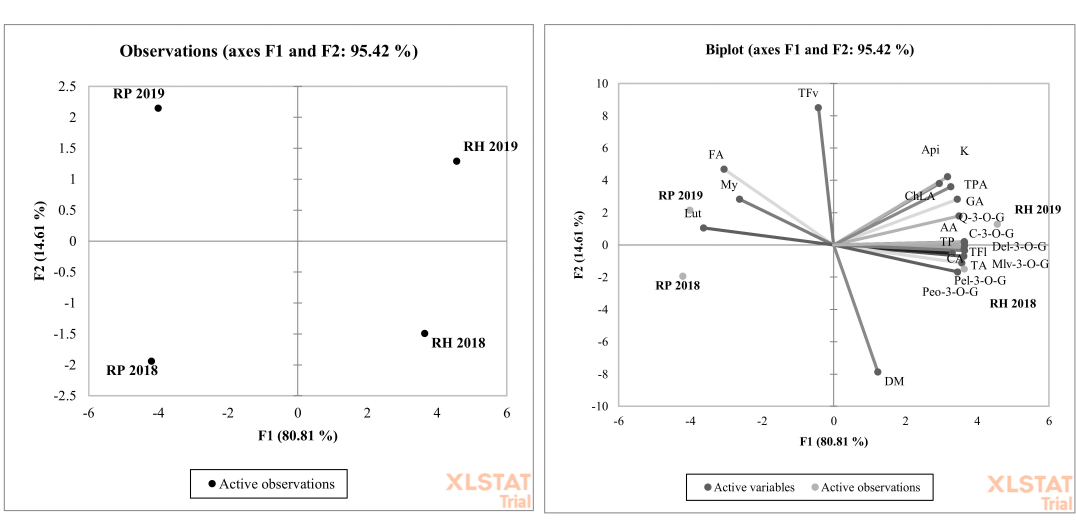
Figure 5. Principal component analysis (PCA) showing the relationship between the polyphenols composition and Robinia species: Robinia pseudoacacia L (RP), Robinia hispida (RH) in two years (2018 and 2019) of experiment. Dry matter (DM,) total polyphenols (TP), total phenolic acids (TPA), gallic acid (GA), ca ff eic acid (CA), ferulic acid (FA), chlorogenic acid (ChLA), total flavonoids (TF), totalflavonols(TFv), quercetin-3- O -glucoside(Q-3- O -G),myricetin(My), apigenin(Api), kaempferol(K), total anthocyanins (TA), cyanidin-3- O -glucoside (Cy-3- O -G), pelargonidin-3- O -glucoside (Pel-3- O -G), malvidin-3- O -glucoside (Mlv-3- O -G), peonidin-3- O -glucoside (Peo-3- O